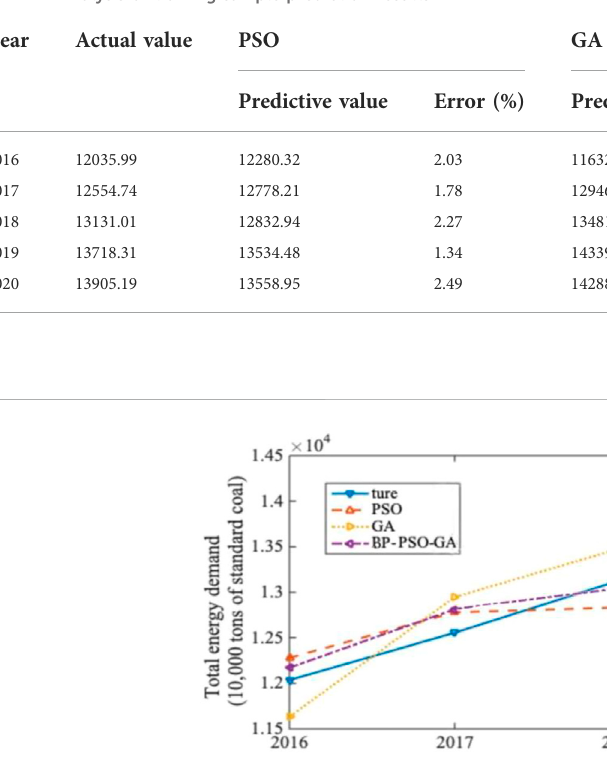
FIGURE 6 Comparison of training sample prediction results.